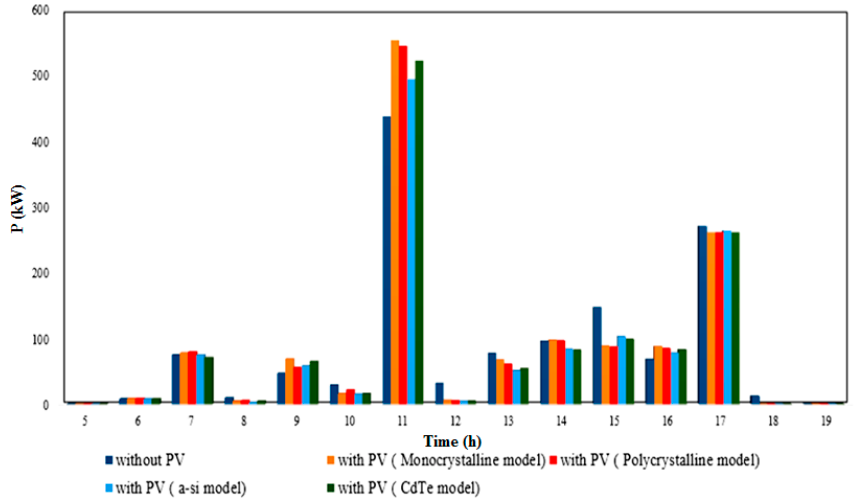
Figure 11. Discharging energy from PL to DSO in August.